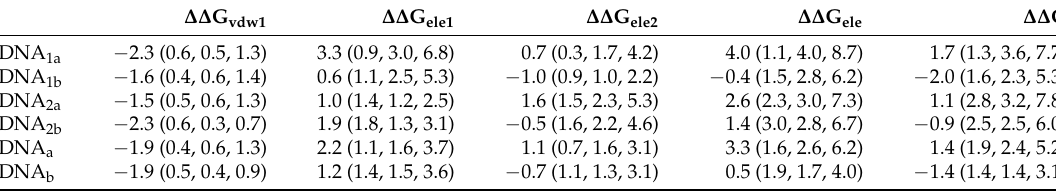
Table 2. Relative free energies of dsDNA formation (kcal/mol).